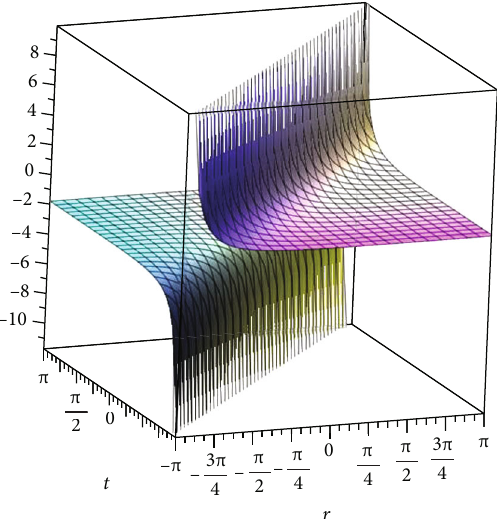
Figure 1: Graphical behavior for ϕ s = 1, and w = 1 . 3